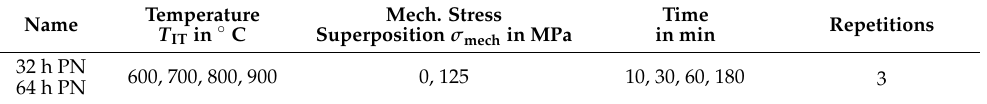
Table 4. Test parameters for the isothermal tempering tests with mechanical stress superposition.